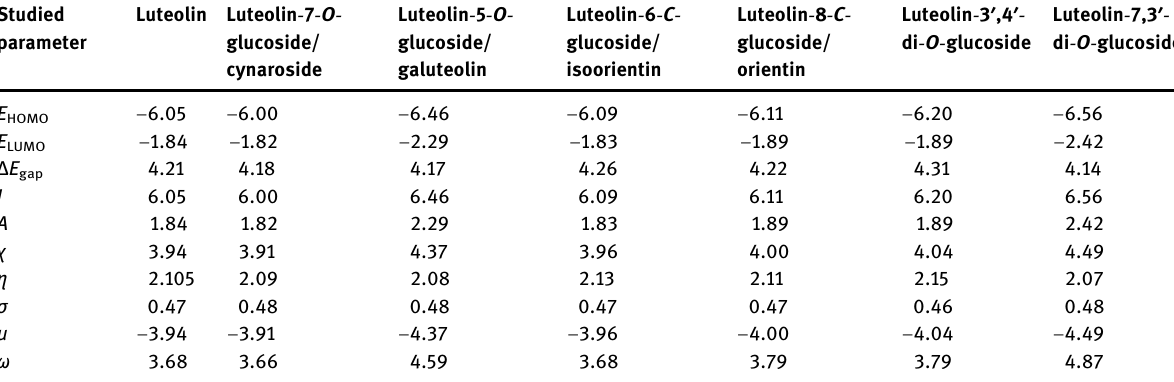
Table 1: Calculated quantum chemical parameters of the studied compounds Studied